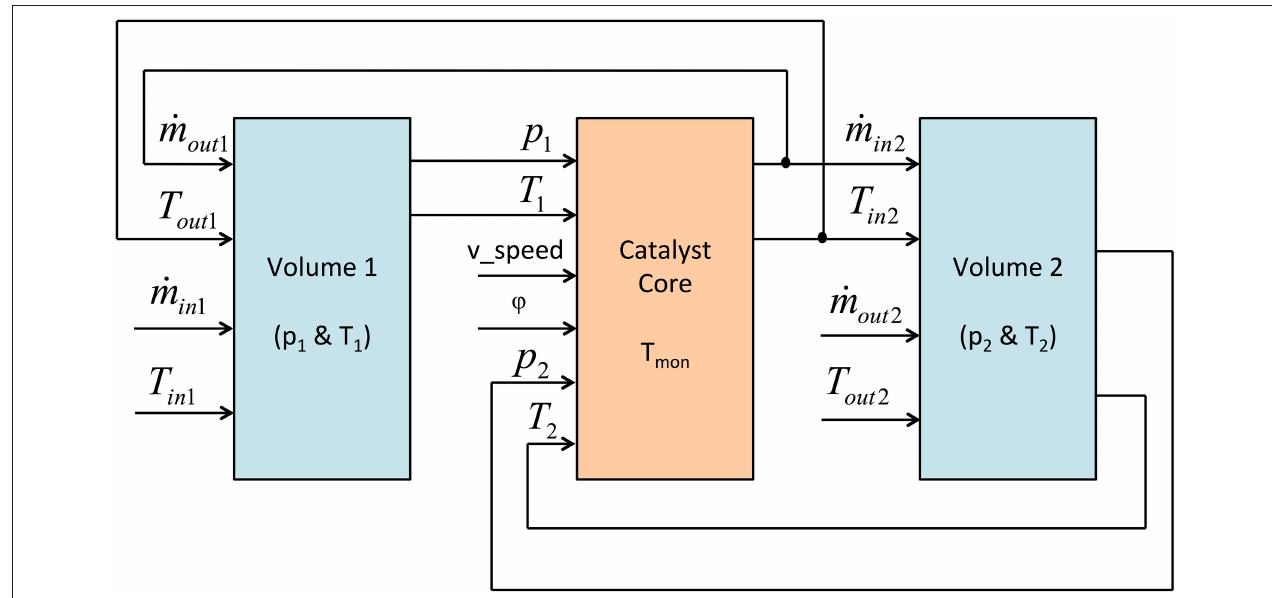
FIGURE 2 | Schematic and causality of the catalyst model.